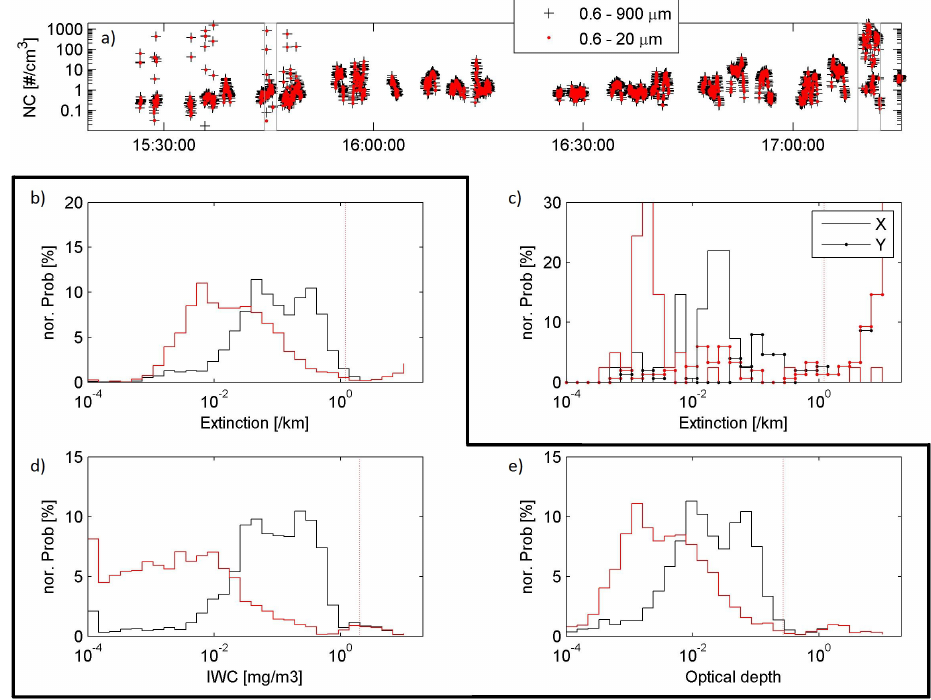
Fig. 14. (a) Time series of particle number concentration for all sizes (black: 0.6–900µm) and for sizes (red: 0.6–20µm), shown only for contrail sampling times. (b) Probability distribution of the extinction for all data points shown in (a) , (c) Probability distribution of extinction for period X (Pass 8 listed in Table 1 – solid lines) and for period Y (the highest concentration sampled 17:10:00 to 17:12:30 – dot markers), both indicated in (a) . (d) Probability distribution of the IWC for all data points shown in (a) . (e) Probability distribution of the optical depth for all data points shown in (a) , assuming a contrail thickness of 200m. Vertical red dashed lines show the mean values reported by Voigt et al.